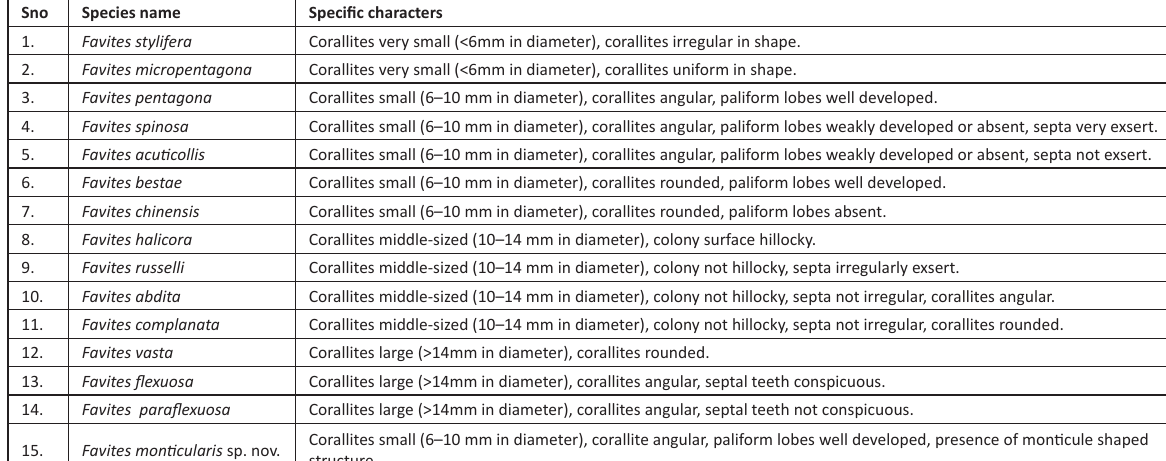
Table 1. Comparison of key characters of different species under genus